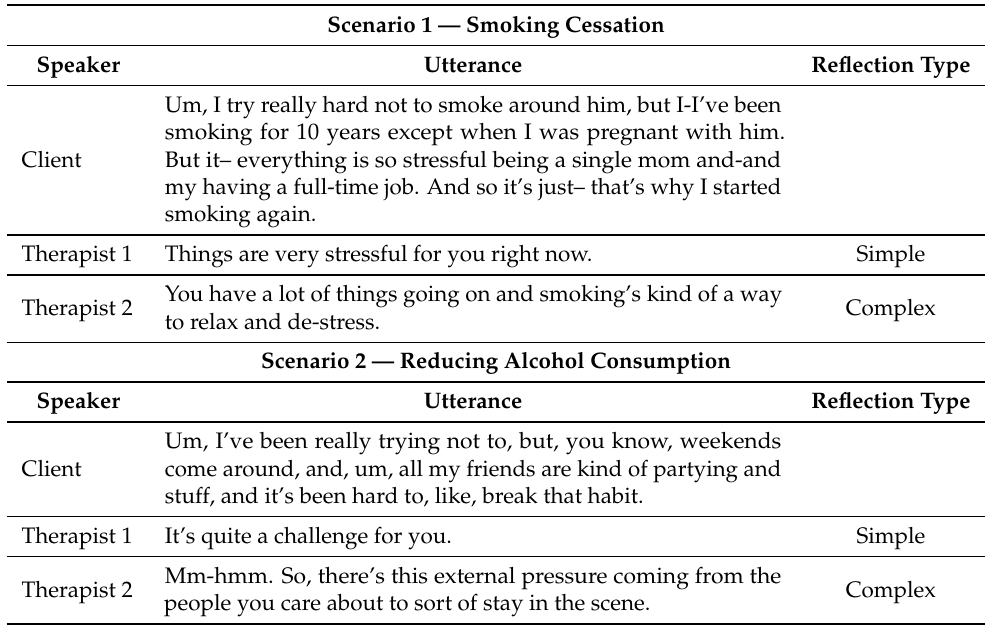
Table 7. Example labelling for therapist Reflection based on the dataset.